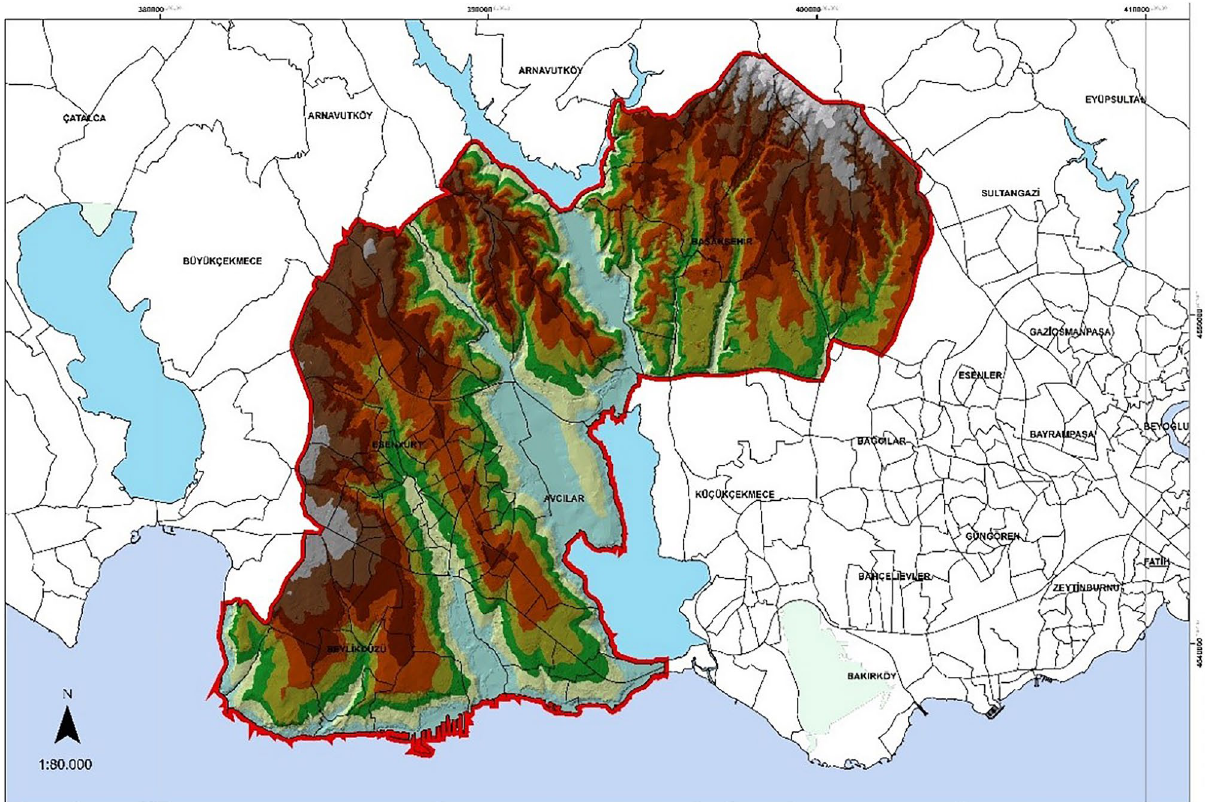
Fig. 5 Study area (illustrated by